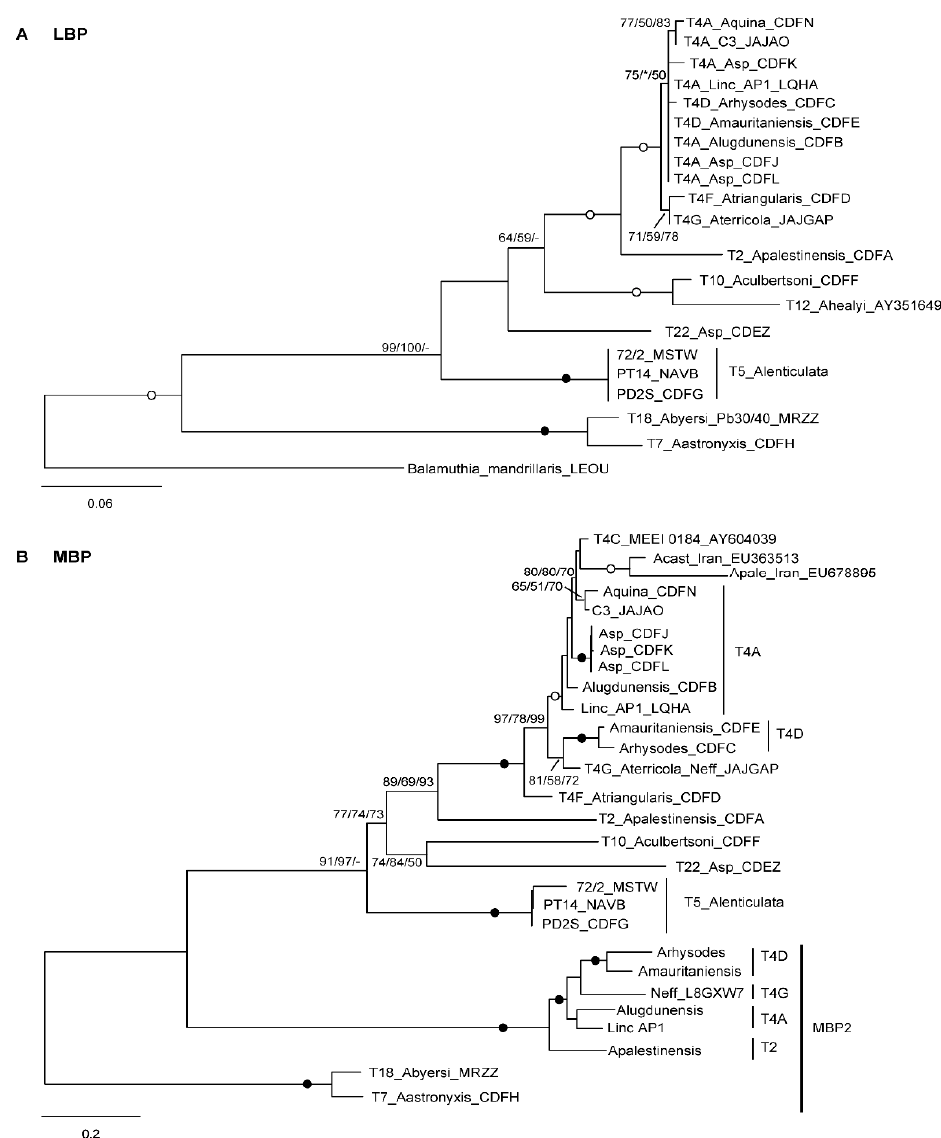
Figure 4. Molecular phylogeny of laminin ( A ) and mannose ( B ) binding proteins. Trees based on amino acid sequences, rooted on the sequence of Balamuthia mandrillaris for LBP ( A ), and on MBP2 for MBP ( B ). At the nodes, bootstrap values (1000 replicates) for ML/ME/MP are shown, with filled and open circles for values 100 or >95% with all methods. *, node recovered but support < 50%; -, node not recovered.